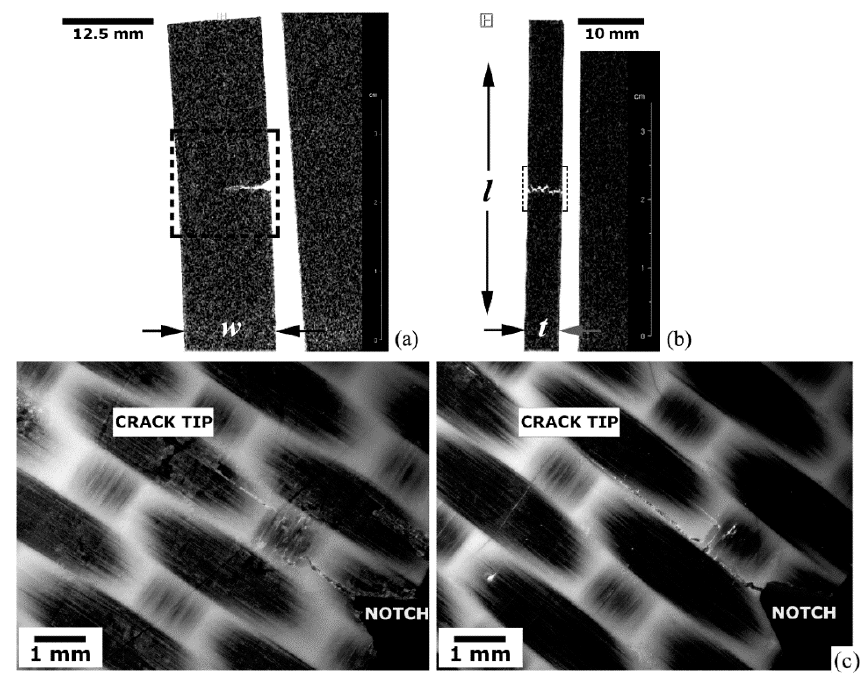
Figure 8. Translaminarly fractured PPS-CF specimen: ( a ) tomographic C-view at mid-thickness of the test coupon; ( b ) S-view at 3.5 one-fourth width from the notched edge of the specimen; and ( c ) stereoscopic images of both l-w surfaces of the specimen, where both the notch and crack tip positions are